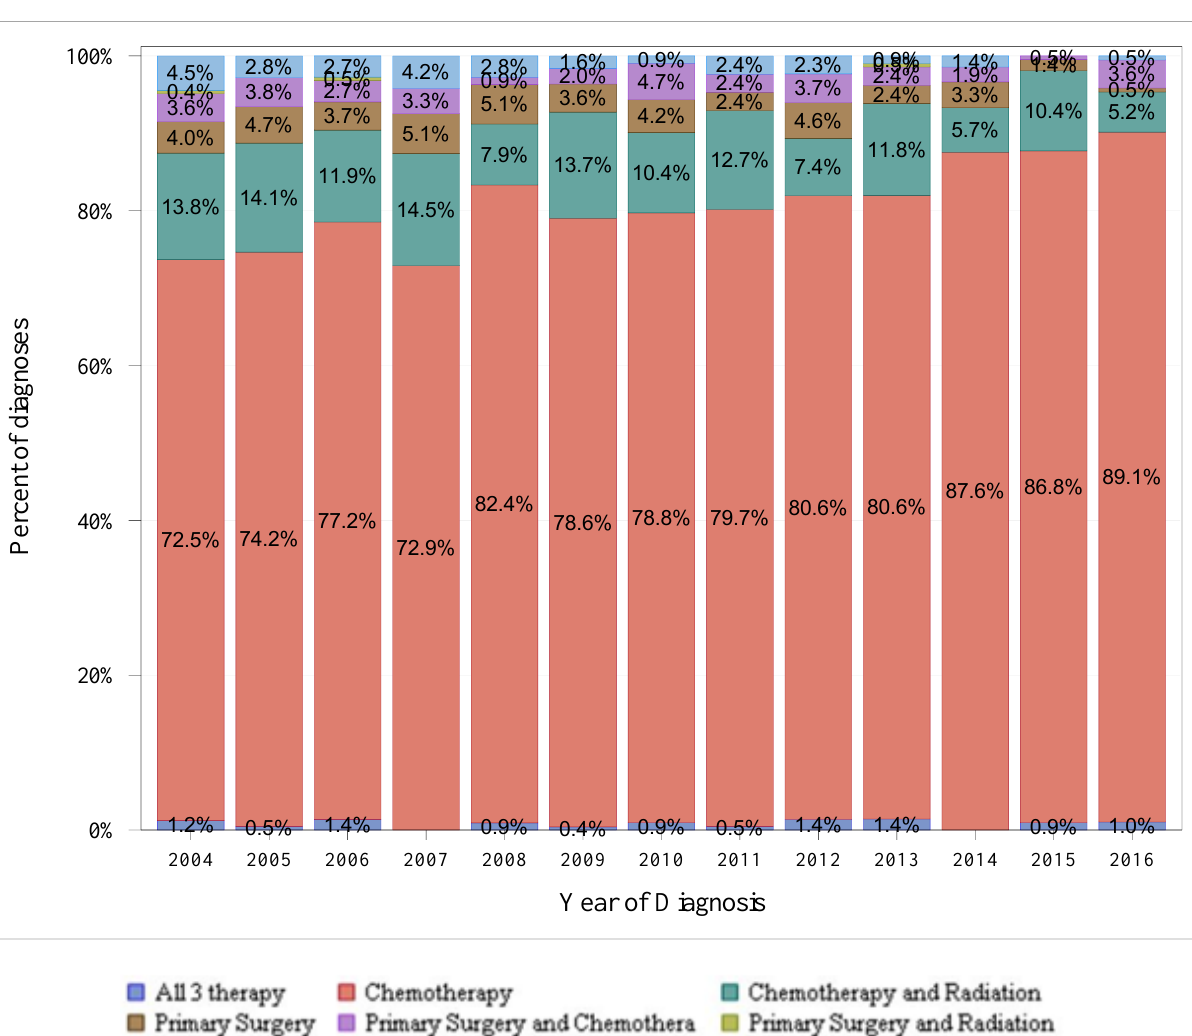
Figure 5. Differences in SEER-18 Distant Stage by Types of Therapy (Excluding pNET), 2004 – 2016, Ages < 50.